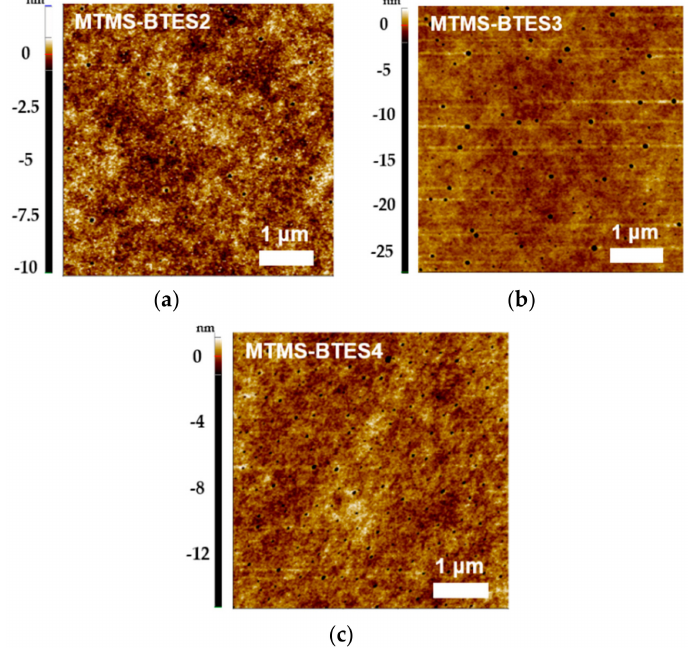
Figure 2. AFM images (5 µ m × 5 µ m) of MTMS-BTES n copolymer gate dielectric films: